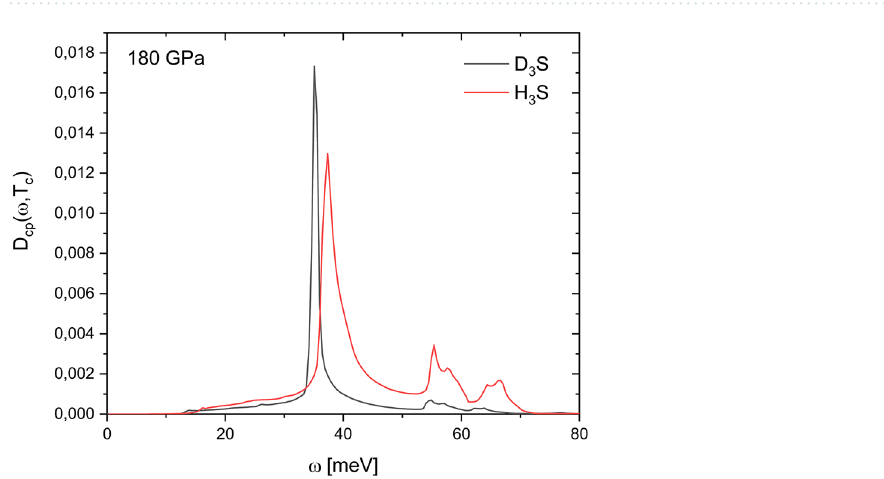
Figure 2. Comparison between ( a ) Eliashberg spectral functions α 2 F (ω) and ( b ) phonon density of states (PhDOS) calculated at 180 GPa for D 3 S (black line) and H 3 S (red line). The highlighted area corresponds to the region where Cooper pairs occur.